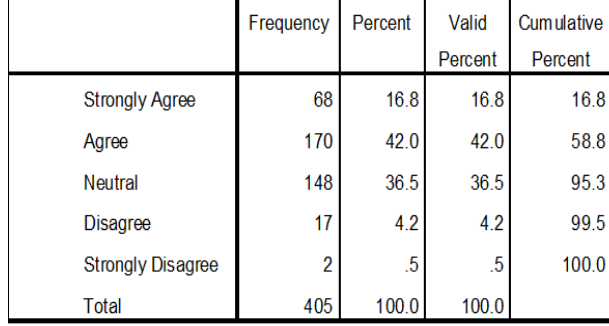
Figure 17. The company is making huge investments on acquiring new technology indicating increasing revenues